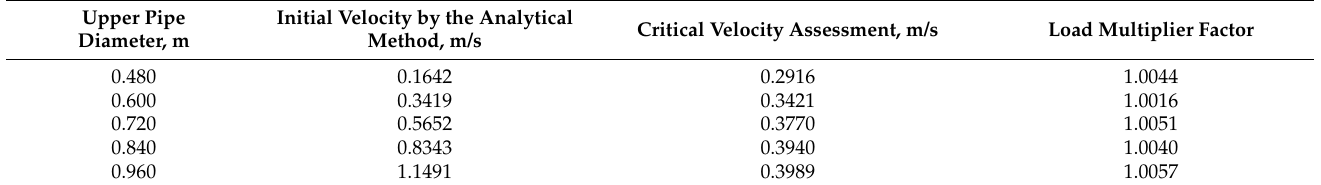
Table 12. The effect of the floatation pipe diameter on the critical velocity, Holding State.